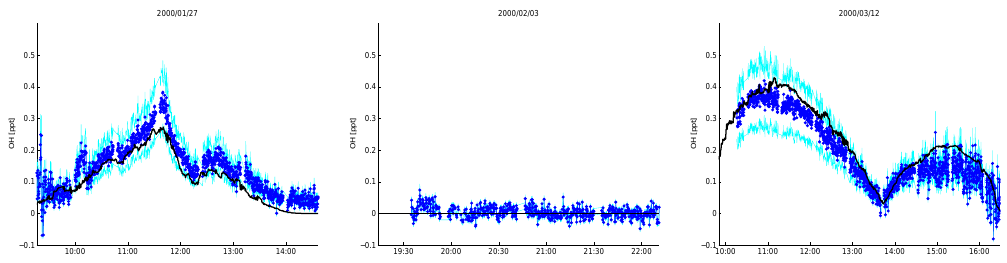
Fig. 10. OH as a function of flight time (UTC) from measurements of selected ER-2 flights (27 January, 3 February, and 12 March) (blue dots, cyan lines show 2 σ accuracy) compared to modeled values (black lines).